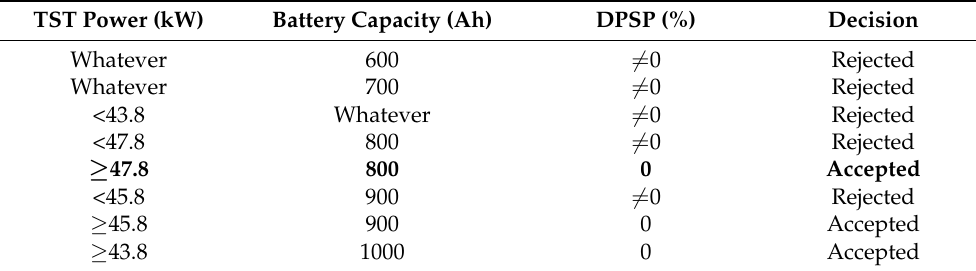
Figure 8. Annual DPSP for different TST power and battery capacity configurations. Table 2. DPSP for different combinations.